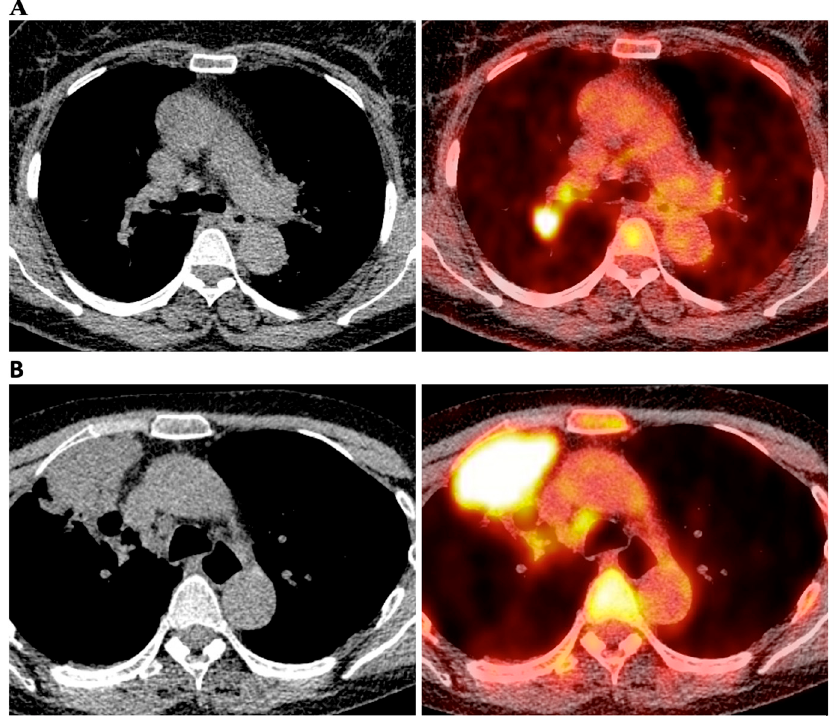
Figure 2. Integrated 18F-FDG-PET/CT scans of the chest. A —clinical N1 situation. B —clinical N2 situation.